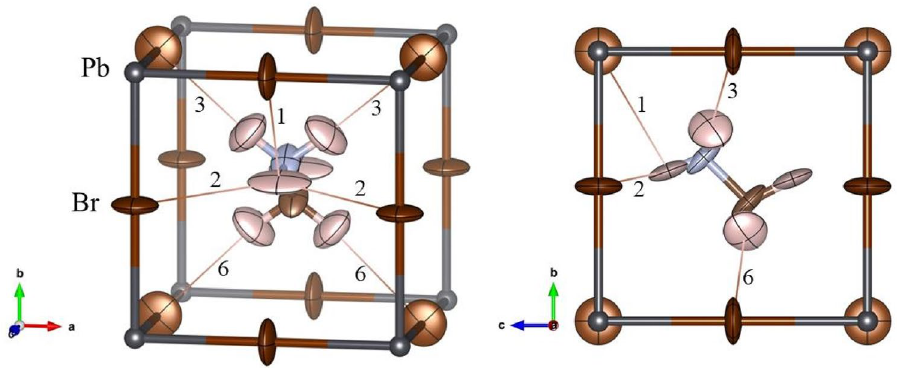
Figure 2. Two views of the cubic crystal structure of MAPbBr 3 , highlighting the H-bond interactions with adjacent Br atoms approximately along [101] ( left ) and [010] ( right ) directions. The numbers correspond to the labels indicated in Table